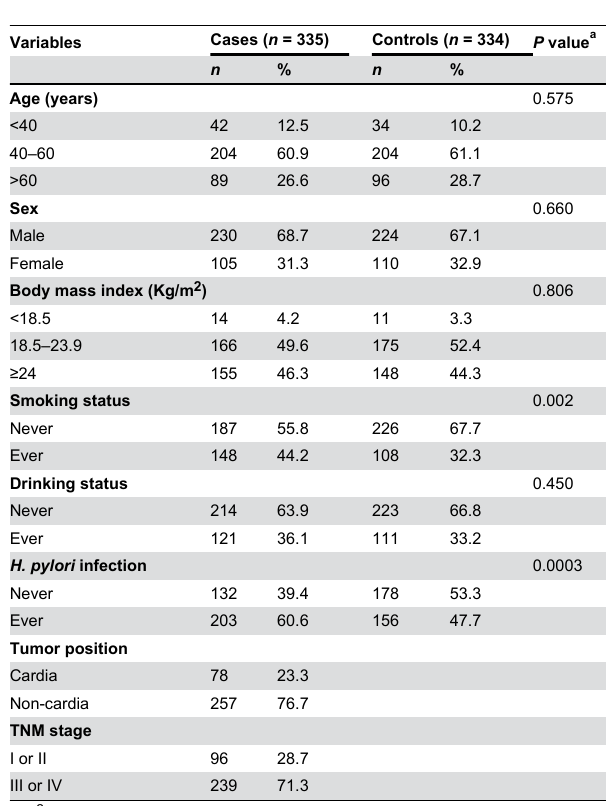
Table 1. Distribution of selected variables in patients with GC and cancer-free